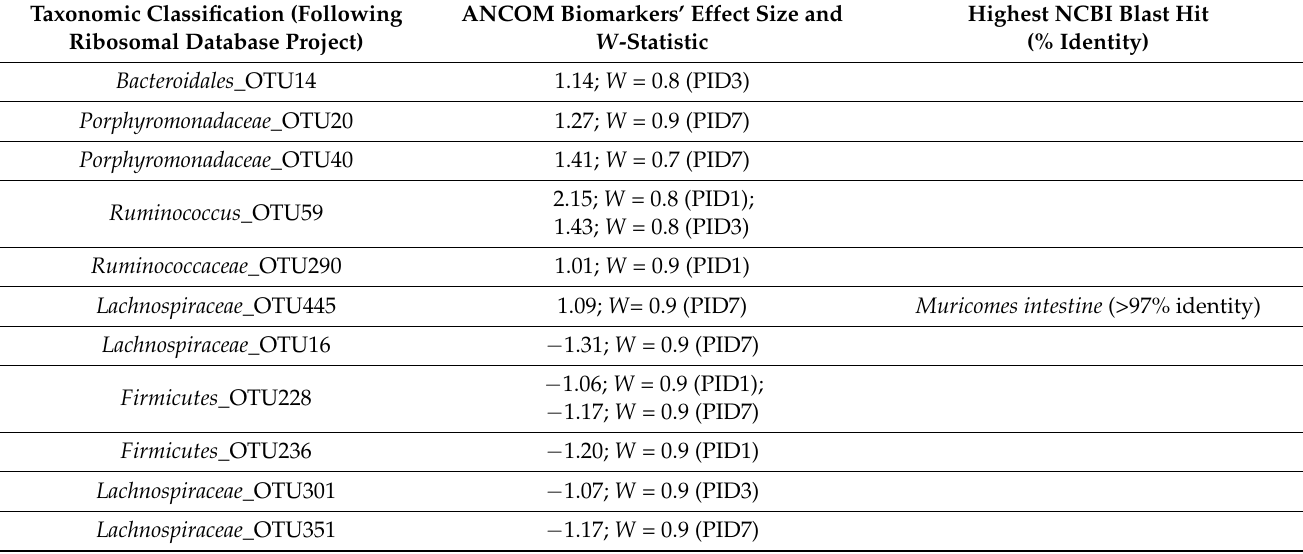
Table 3. Differential operational taxonomic units (OTUs) detected in L. rhamnosus GG-given mice following pelvic irradiation. PID = post-irradiation